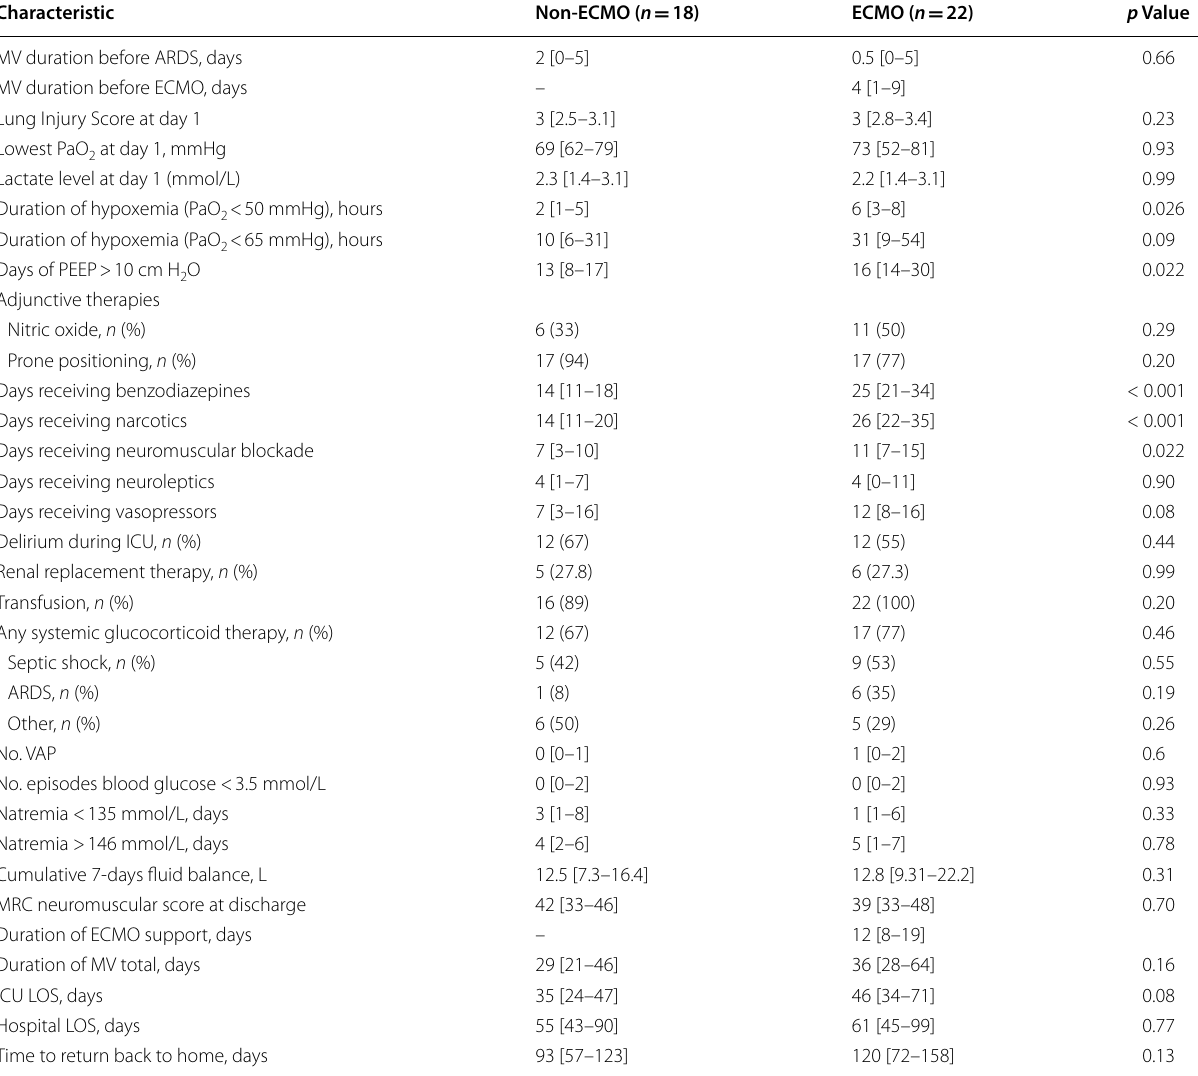
Table 2 Characteristics of the patients during the ICU